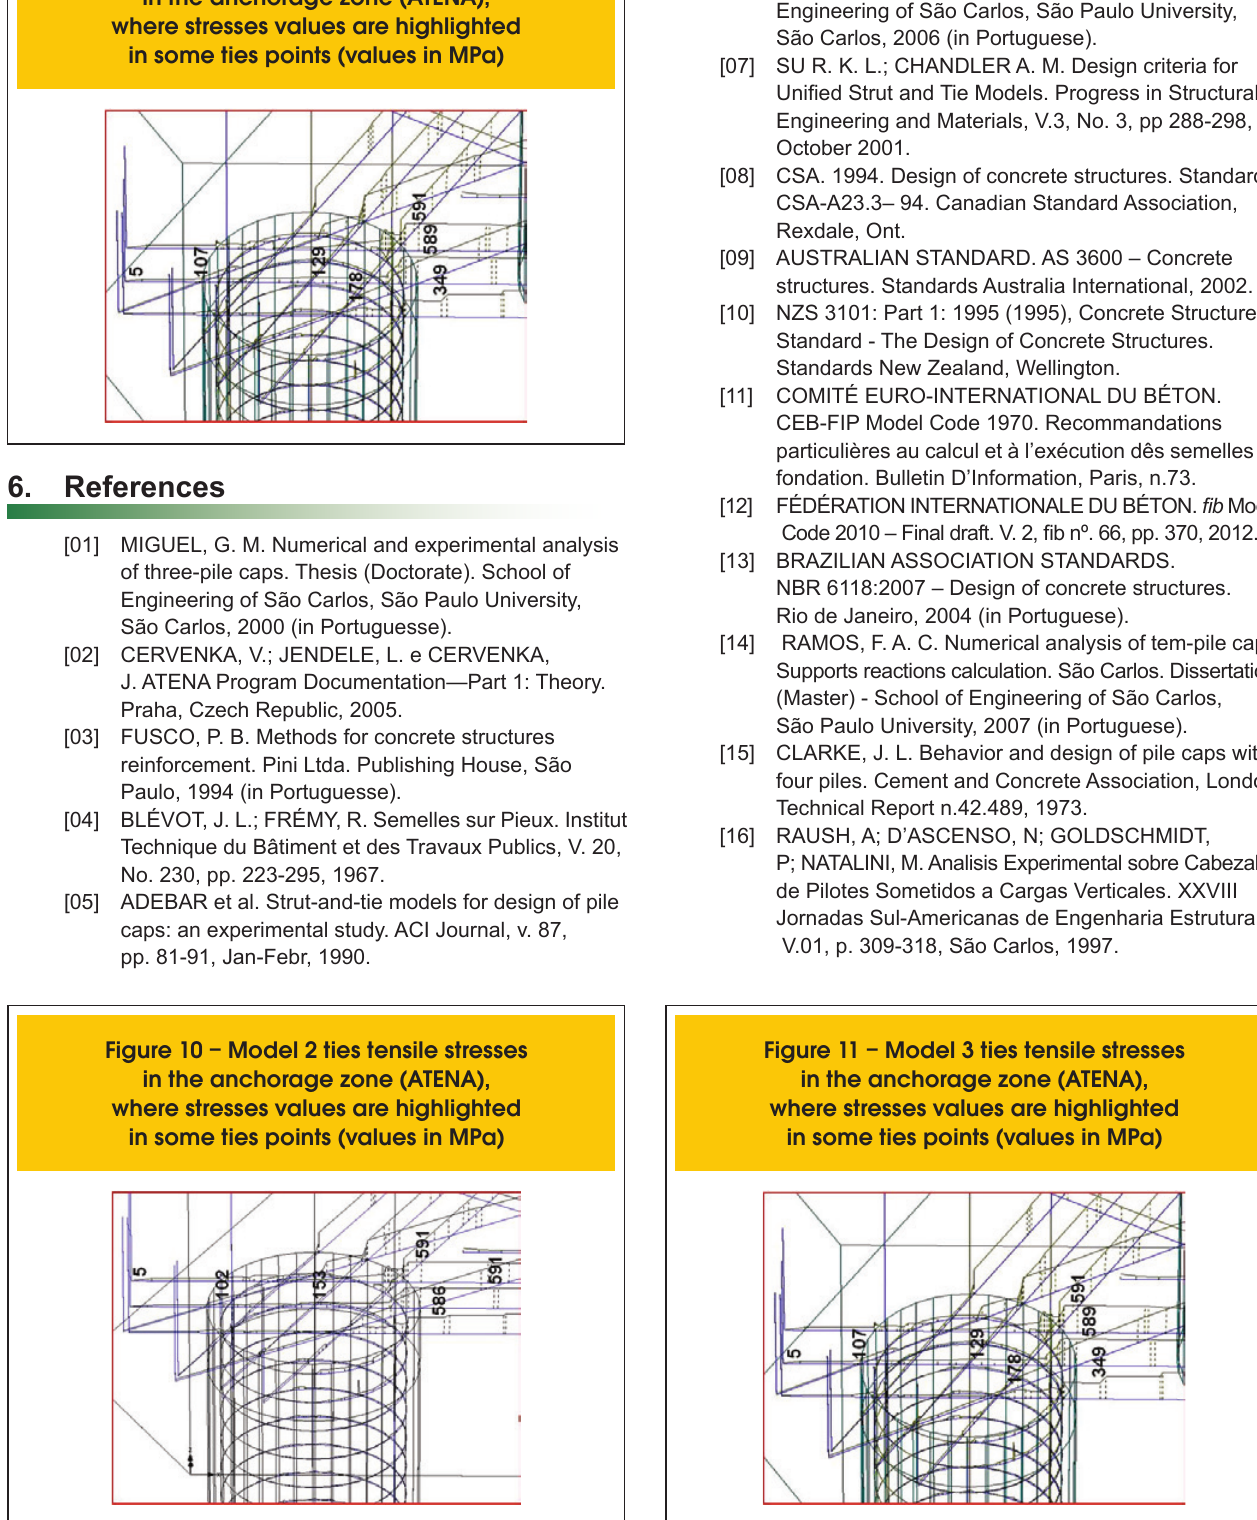
Figure 9 – Model 1 ties tensile stresses in the anchorage zone (ATENA), where stresses values are highlighted in some ties points (values in MPa)